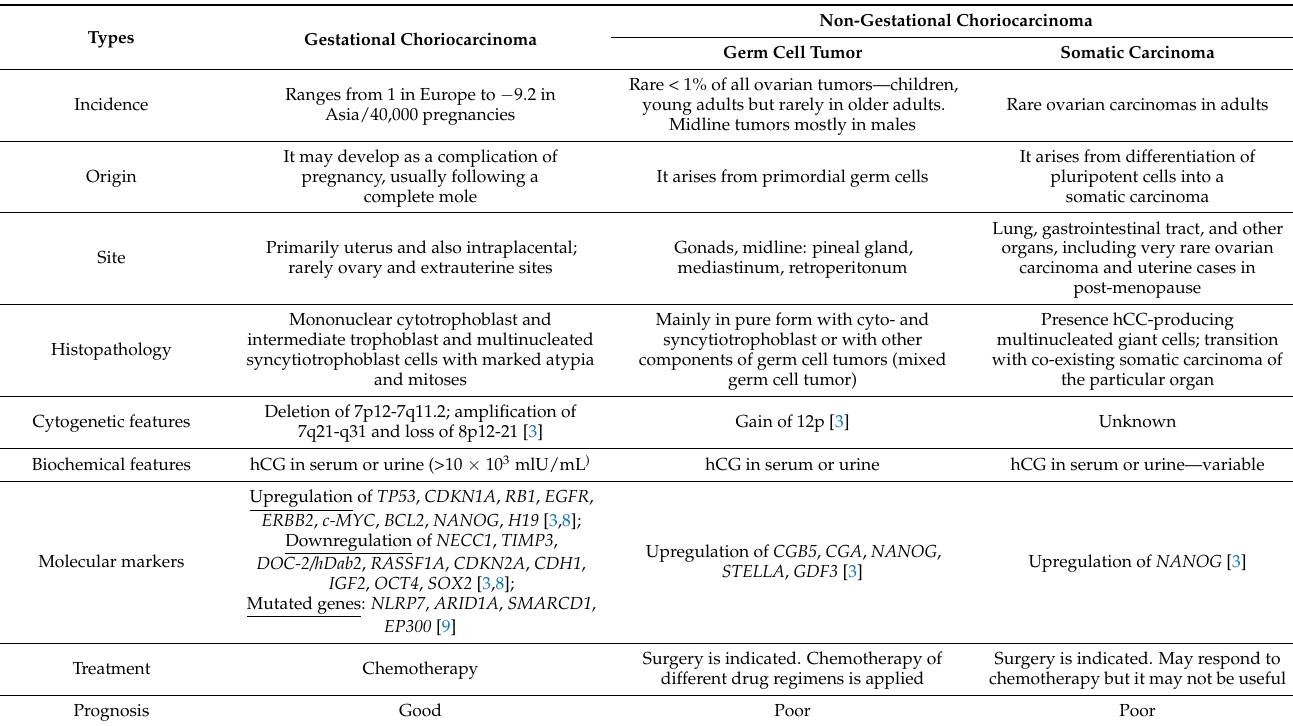
Table 1. Summary of the features of choriocarcinoma—adapted from Cheung et al.